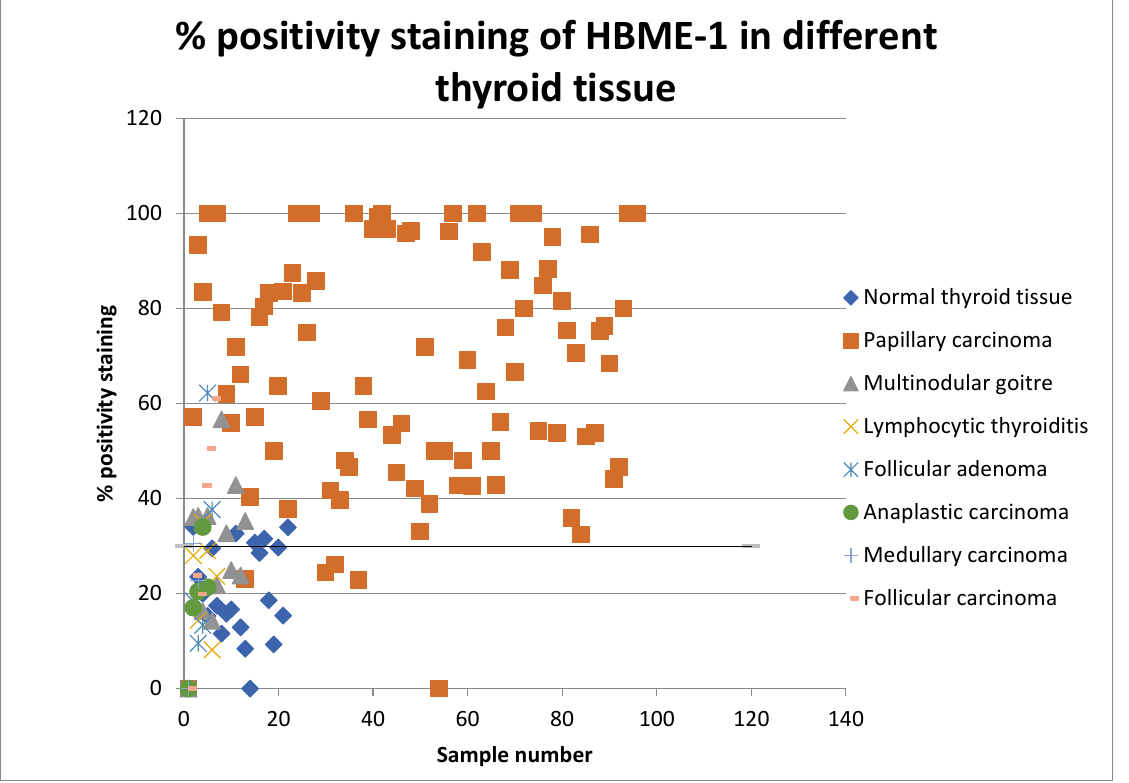
Figure 2. Scatter graph showing percentage positivity staining rates of HBME-1 in all types of thyroid tissue in 2008 and